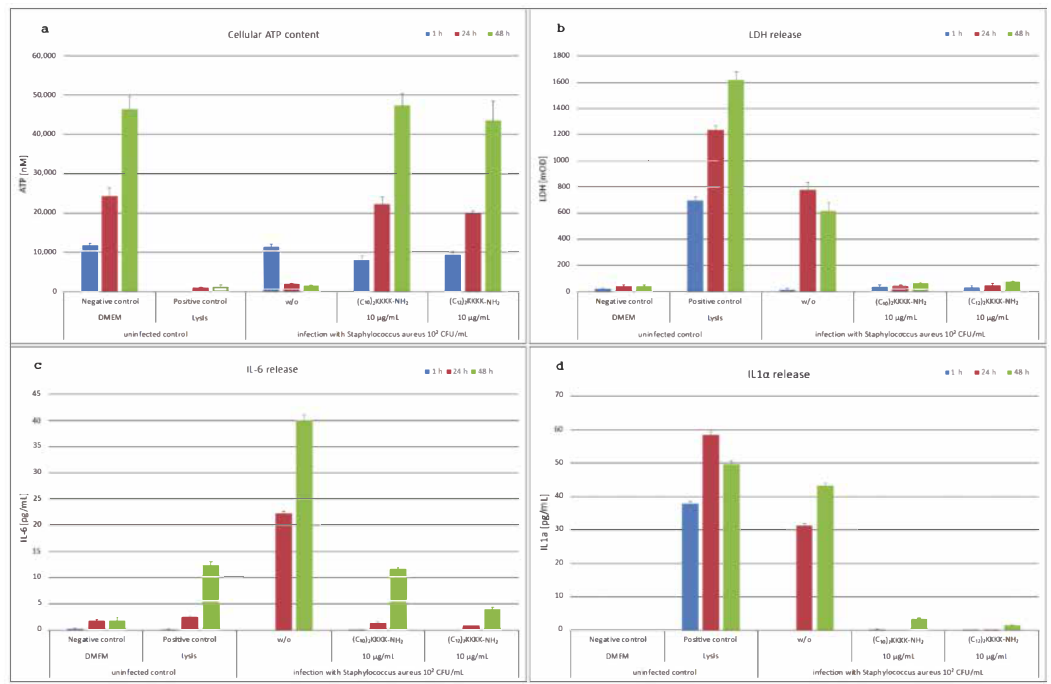
Figure 2. The coculture model of HaCaT keratinocytes infected with Staphylococcus aureus during incubation for 1 h, 24 h, and 48 h with (C 10 ) 2 -KKKK-NH 2 and (C 12 ) 2 -KKKK-NH 2 compared to the uninfected controls. In panel ( a ), the cellular ATP content of the S. aureus -infected samples